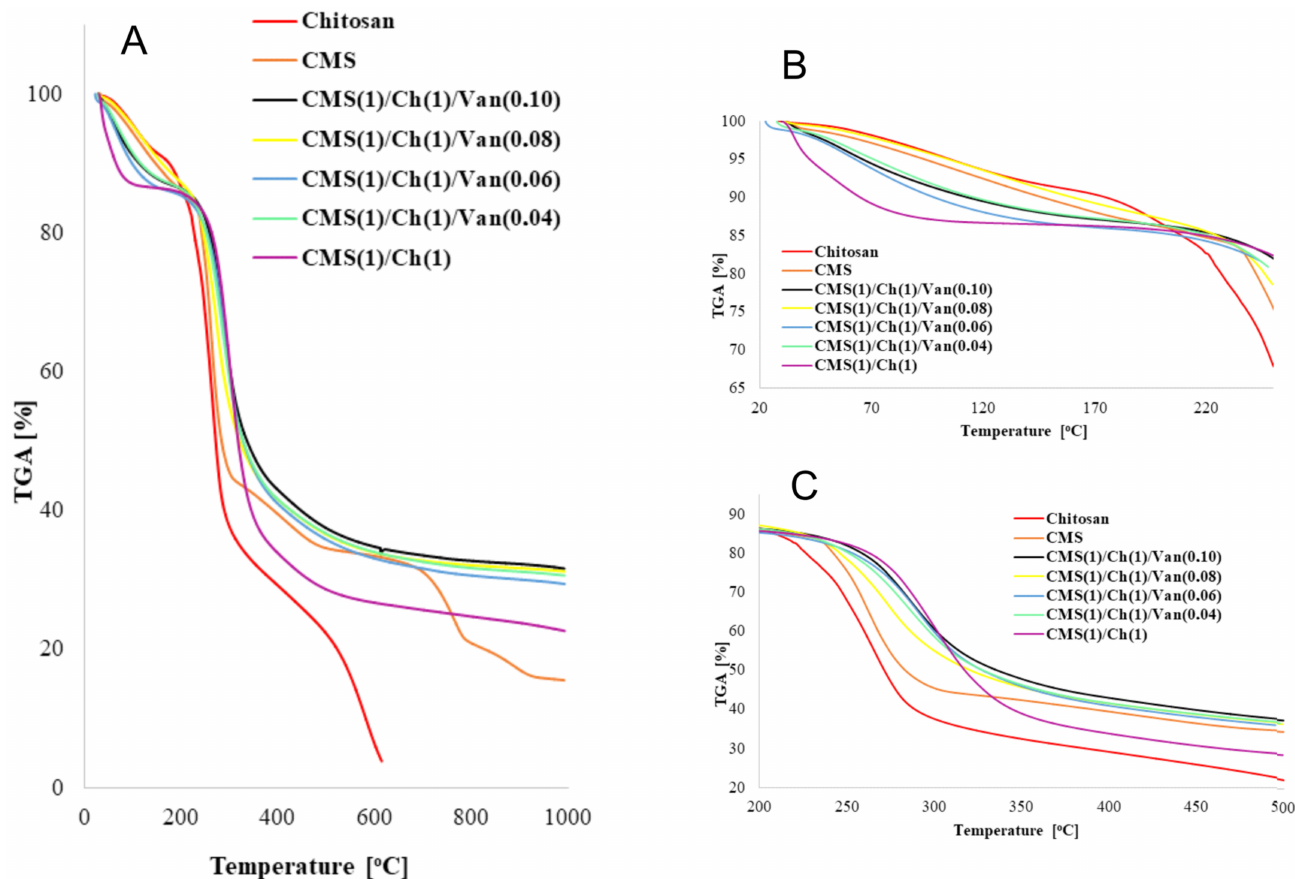
Figure 4. TG curves for complex superabsorbent polymers Ch and CMS in the ratio 1:1 with the addition of 0.04; 0.06; 0.08; 0.10 Van and without Van with curves for raw monomers (Ch and CMS) in various temperature ranges ( A ) the entire temperature range (0–1000 ◦ C), ( B ) in the temperature range 20–250 ◦ C and ( C ) in the temperature range 200–500 ◦